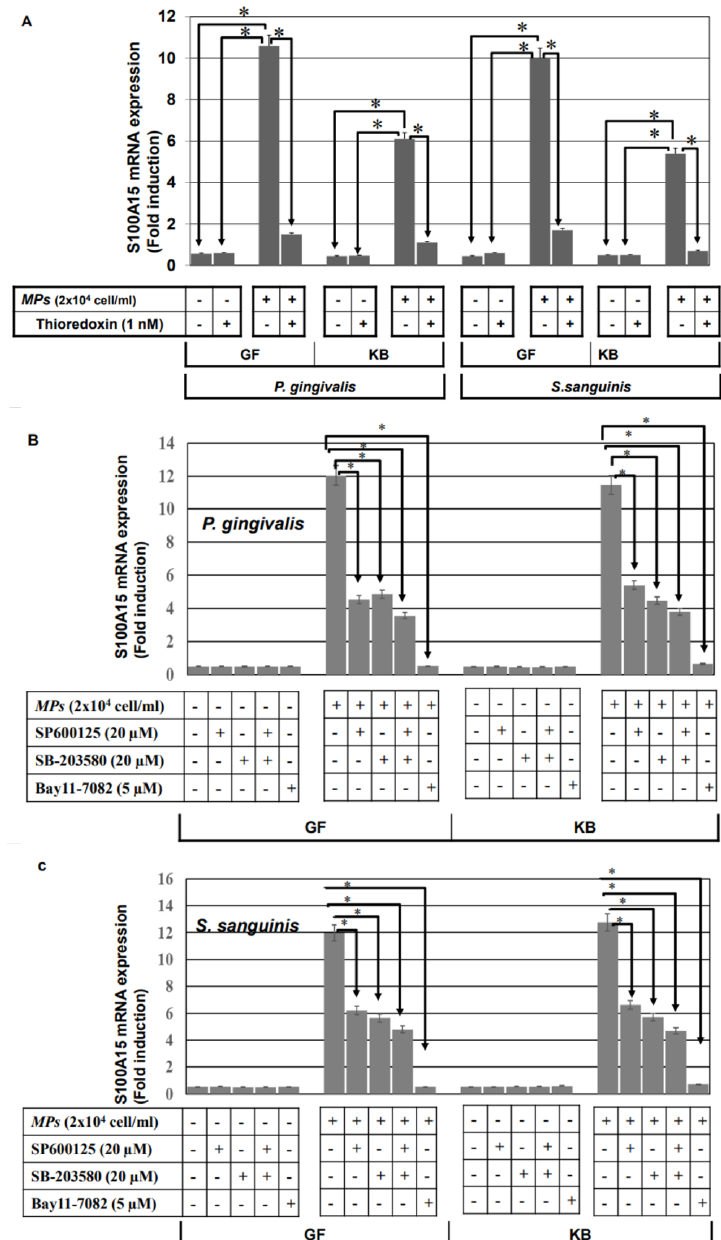
Figure 6. Bacterial pathogens-induced expression of S100A15 in oral mucosa-derived cells is mediated by the MAP kinase and NF- κ B pathways. ( A ) GF and KB cells were pre-treated with Thioredoxin 1 h prior to stimulation with either heat-inactivated gram − P. gingivalis or heat-inactivated gram + S. sanguinis for 48 h. Total RNA was extracted from treated and control cells and subsequently subjected to qRT-PCR analysis to assess the relative transcription levels of S100A15. ( B ) GF and KB cells were pre-treated with inhibitors of JNK (SP600125), p38 (SB-203580), or NF- κ B (Bay11-7082) 1 h prior to stimulation with either heat-inactivated P. gingivalis or heat-inactivated S. sanguinis for 48 h. Total RNA was extracted from treated and control cells and subsequently subjected to qRT-PCR analysis to assess the relative transcription levels of S100A15. ( C ) GF and KB cells were pre-treated with SP600125, SB-203580, or Bay11-7082 1 h prior to stimulation with heat-inactivated P. gingivalis or heat-inactivated S. sanguinis for 48 h. Total RNA was extracted from treated and control cells and subsequently subjected to qRT-PCR analysis to assess relative transcription levels of S100A15. Densitometric quantification of S100A15 mRNA over actin mRNA transcript. Each bar represents the mean ± SD of three independent experiments performed in duplicate, * p <